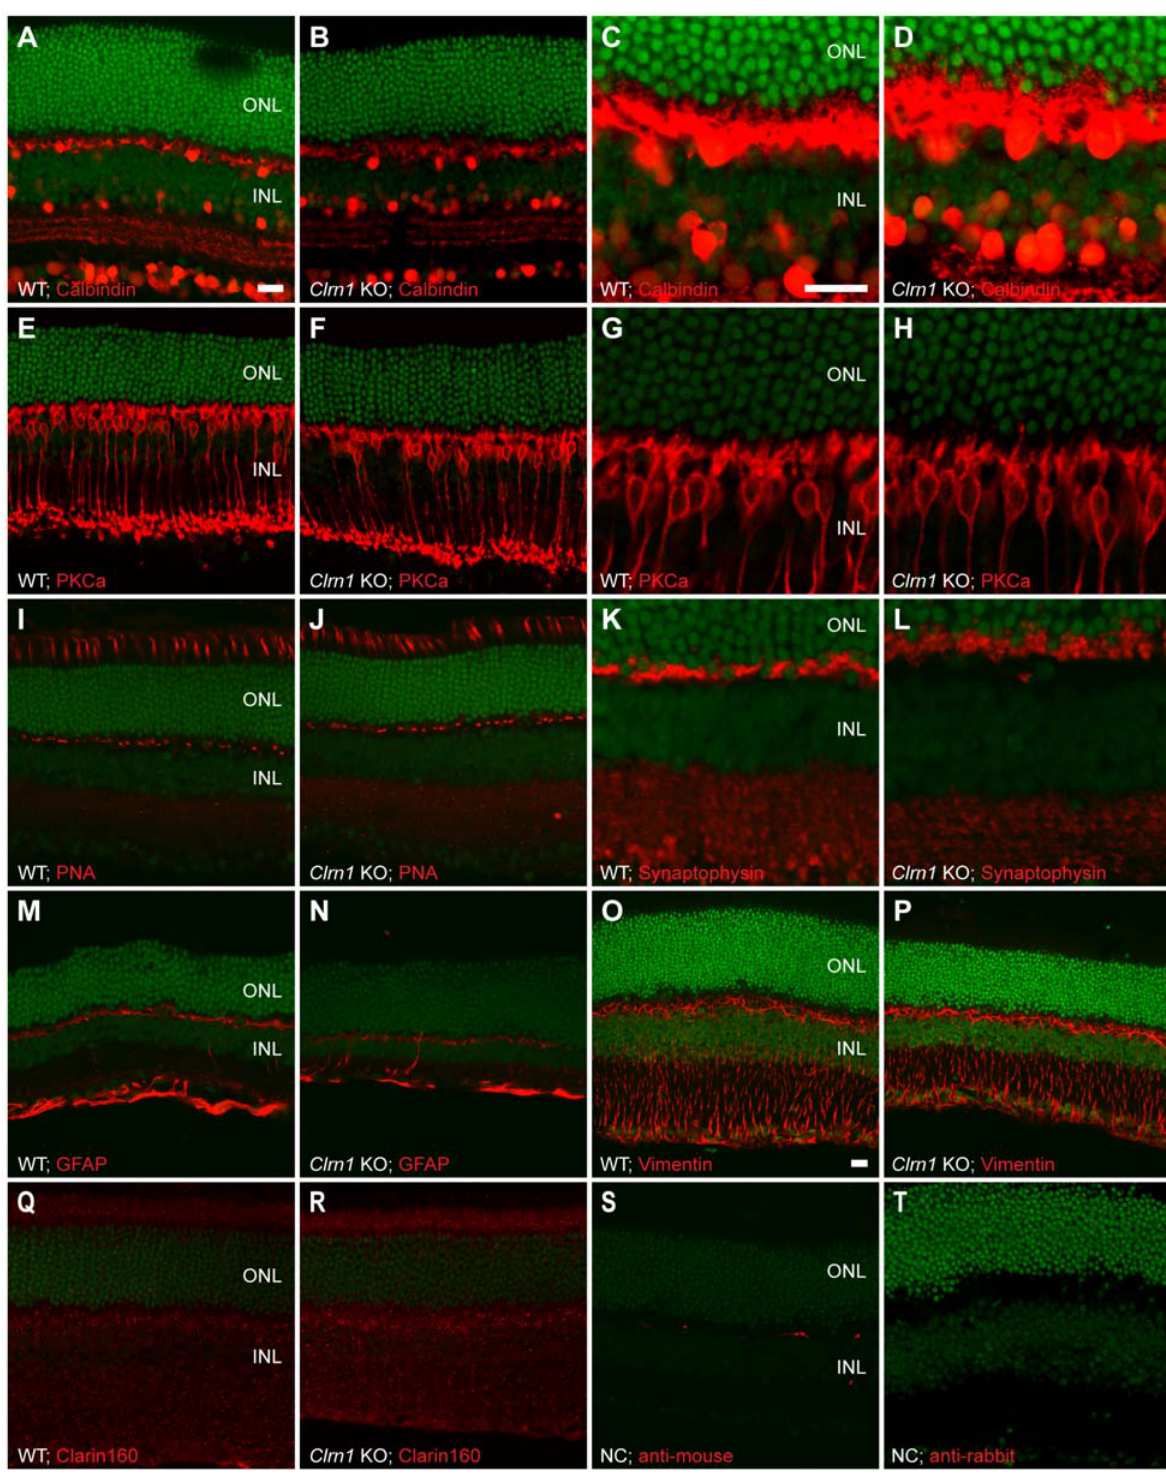
Figure 7. Immunohistochemical analysis of littermate WT ( + / + ) and Clrn1 KO ( 2 / 2 ) mouse retinas. (A–D) WT and KO retinas stained with an antibody to Calbindin, shown at low (A and B) and high (C and D) magnifications. (E–H) WT and KO retinas stained with an anti-PKC-alpha antibody at low (E–F) and high (G–H) magnifications. (I,J) WT and KO retinas labeled with the rhodamine-conjugated peanut agglutinin (PNA) lectin. (K,L) WT and KO retinal sections immunostained with anti-Synaptophysin antibodies, shown at high magnification. (M–P) WT and KO retinal sections stained with intermediate filament antibodies to GFAP (M,N) and vimentin (O,P). (Q,R) Immunostaining with a candidate antibody made to CLRN1 (the Clrn1 gene product) in WT (Q) and KO (R) retinas. (S,T) Control images showing labeling by the secondary antibodies alone. Scale bar=20 m m in all images. Scale bars: In A applies to A–B, E–F, I–J, M–N, and Q–T; in C applies to C–D, G–H, and K–L; in O, applies to O–P. INL=inner nuclear layer, ONL=outer nuclear layer. SYTOX Green was used as the nuclear counterstain.